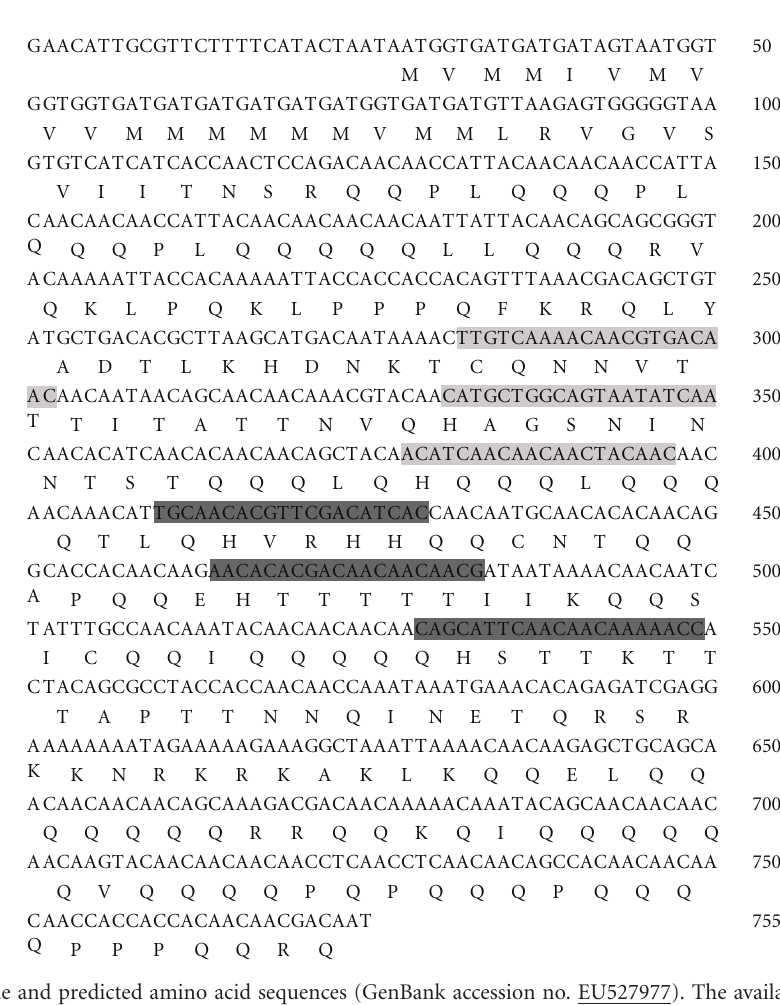
Figure 3: Tpr nucleotide and predicted amino acid sequences (GenBank accession no. EU527977). The available ORF encodes a protein domain that contains ∼ 34% glutamine. Shaded sequences identify the positions of oligonucleotides TprA (330–350), TprB (378–397), TprC (410–429), TprD (464–483), Tpr1 (292–302), and Tpr2 (529–549) that were employed for microinjections, RACE-PCR and RT-PCR (see Section 2).